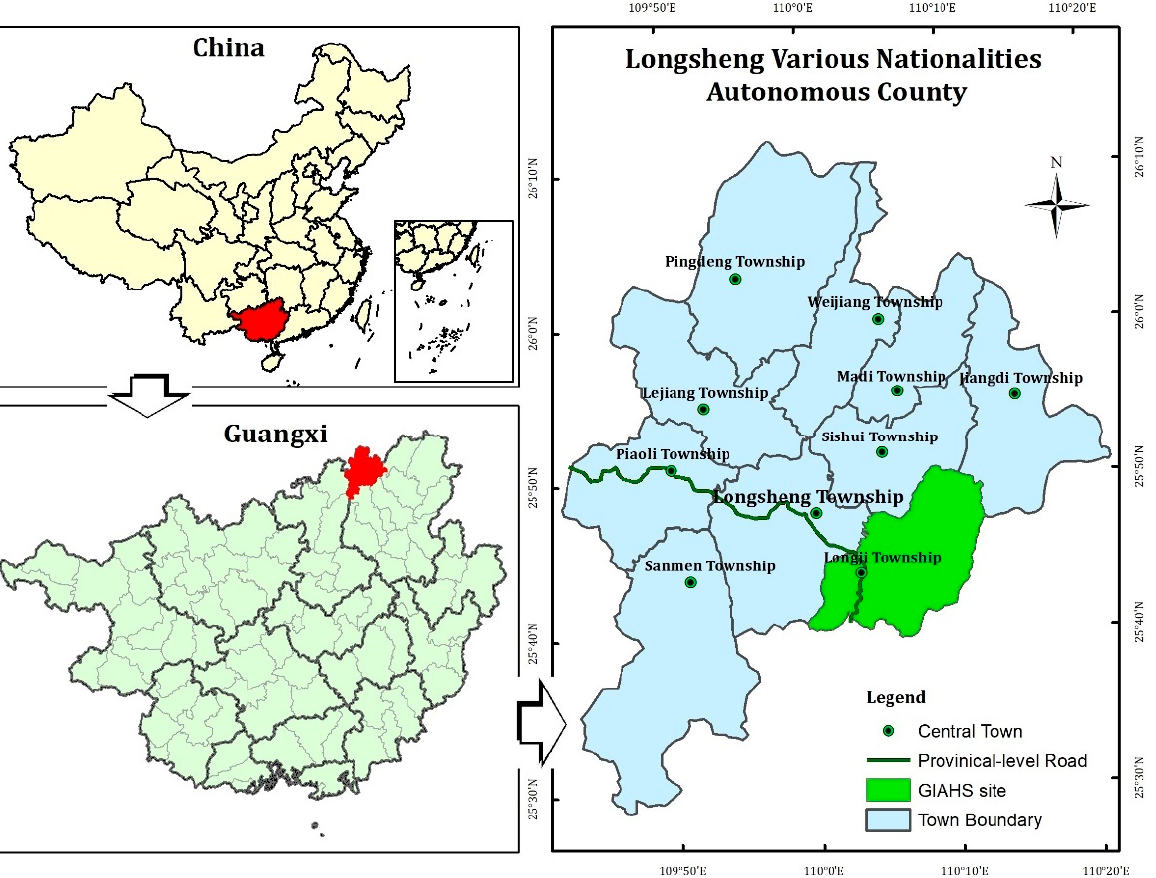
Figure 8. Location of Longji Terraces and scope of the GIAHS site.